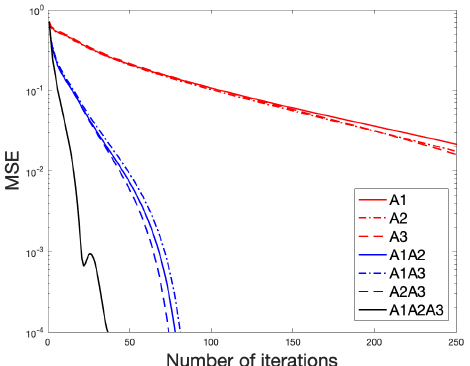
Figure 12. The graphs of the MSE for Algorithm 1 with the input A i , i =